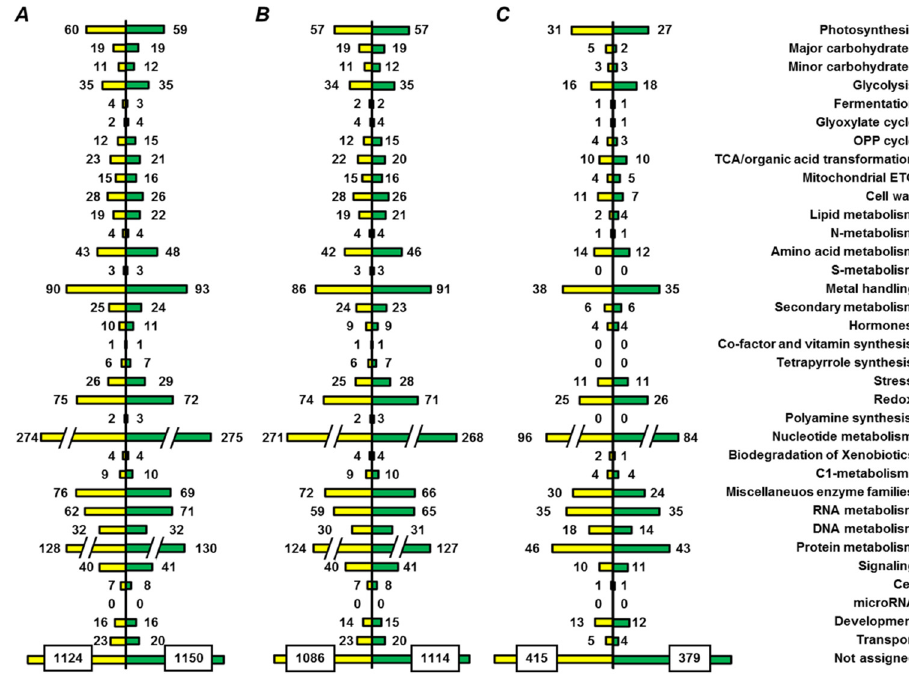
Figure 5. Functional annotation of proteins, identified in yellow seeds of cultivar Millennium (yellow color) and in green seeds of cultivar Gloriosa (green color), ( A ) both in nondepleted samples and after treatment with 0.07% ( w/v ) protamine sulfate, ( B ) only in nondepleted fraction and ( C ) protamine-sulfate supernatant fraction.